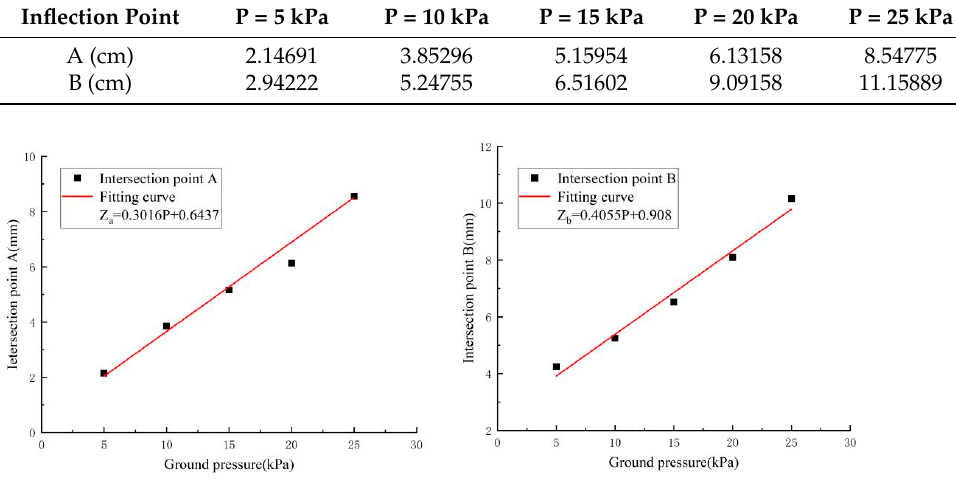
Figure 5. The relationship between the ground pressure and the depths of inflection points A and B in the pressure–sinkage versus loading time curves (Figure 4).